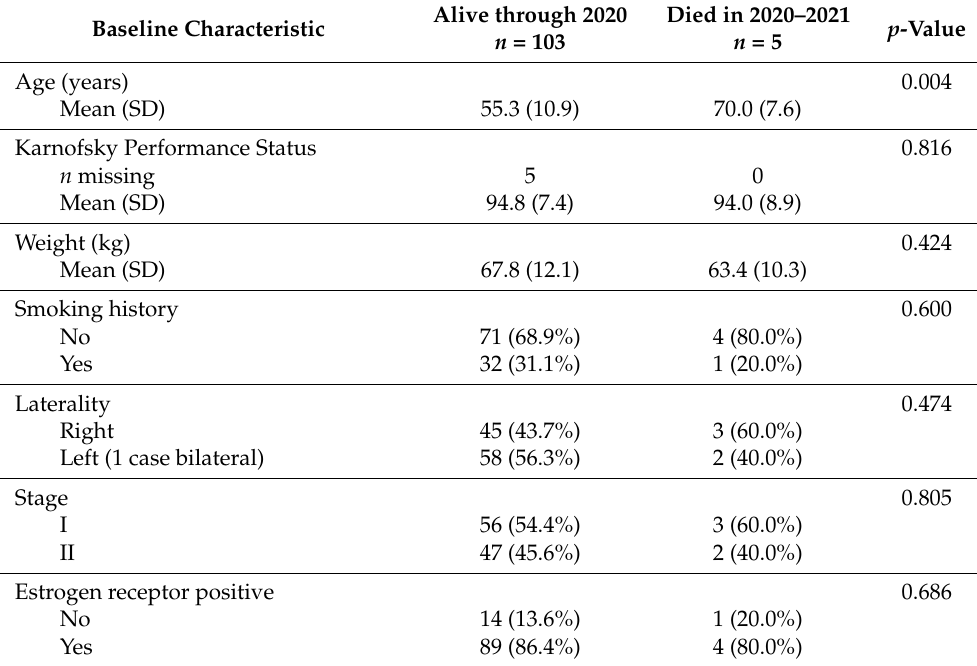
Table 5. Baseline characteristics of patients who survived or died in